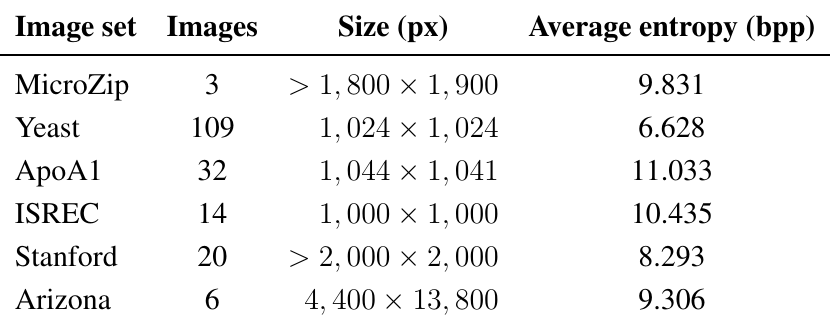
Table 4. Image sets used in the literature and in this work. All images are 16